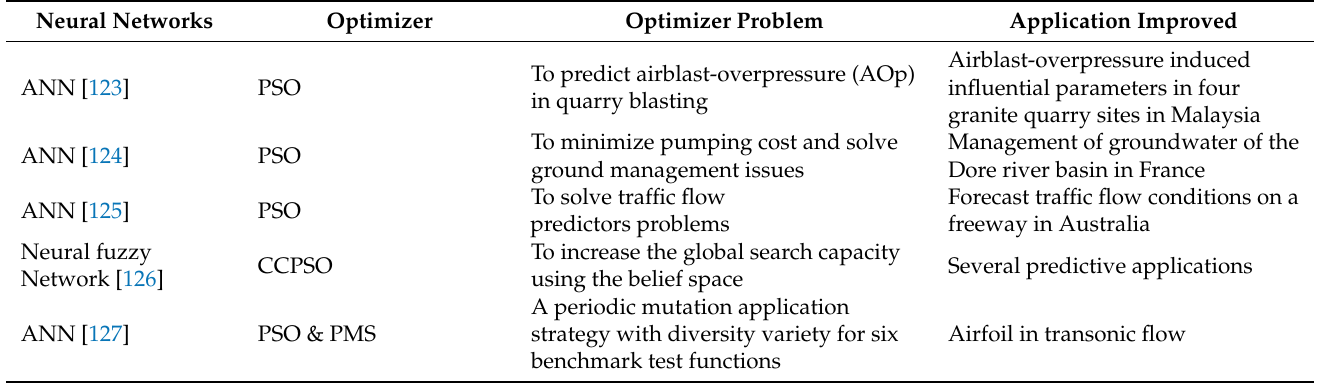
Table 3. Studies involving PSO for neural networks design and application